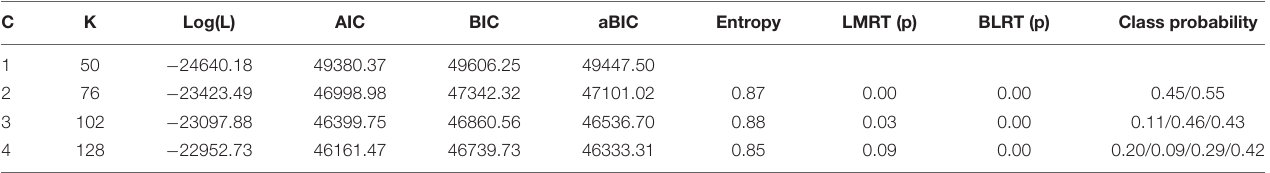
TABLE 1 | Latent profile analysis of the differing psychological capital among the participants.